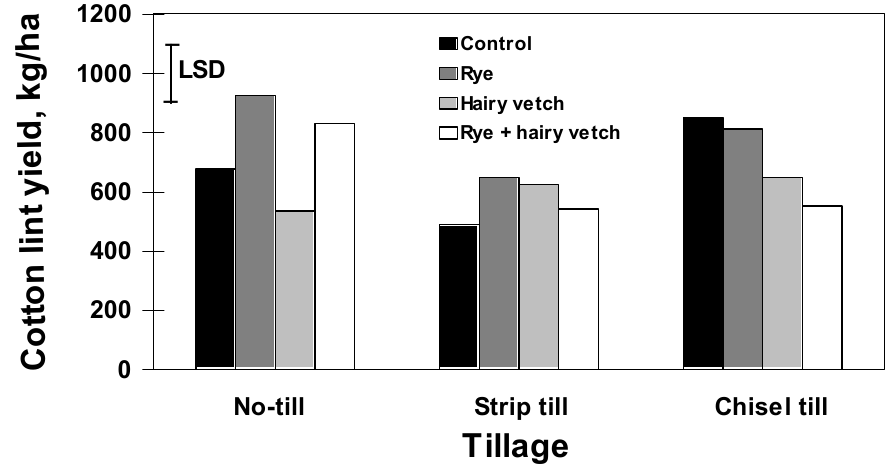
FIGURE 5. Cotton lint yield as influenced by tillage and cover crops averaged across N fertilization rates (0, 60, and 120 kg N/ha) and years (2000 and 2002). LSD denotes least significant difference at p < 0.05.